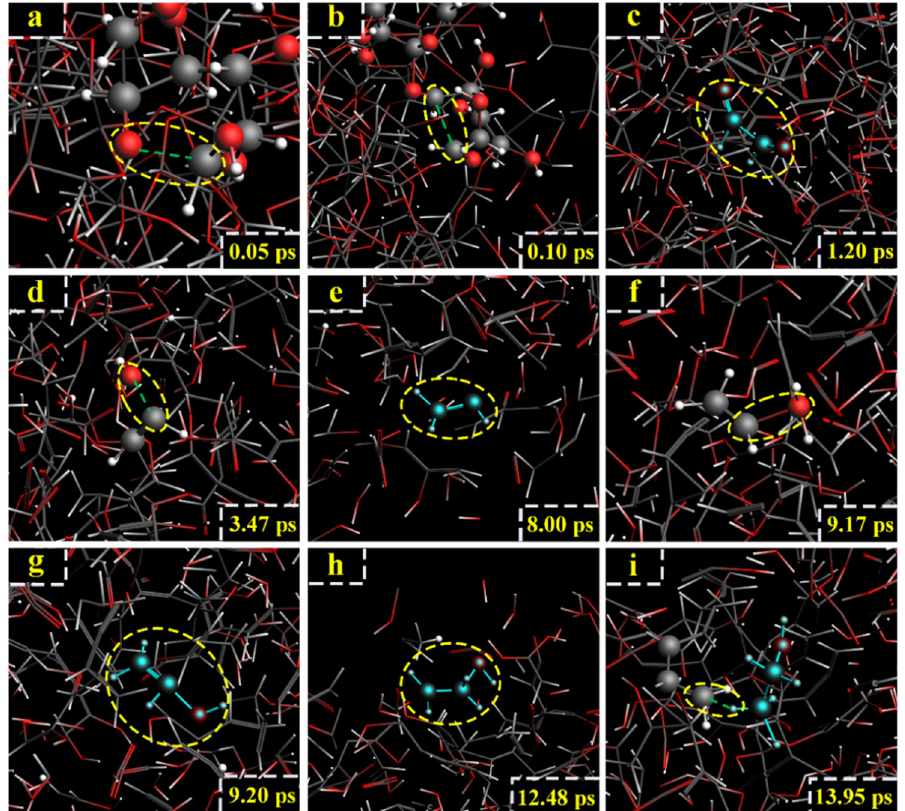
Figure 13. Path II for the production of ethanol. ( a – i ) are the procedure of cellobiose to produce ethanol at 2800 K.